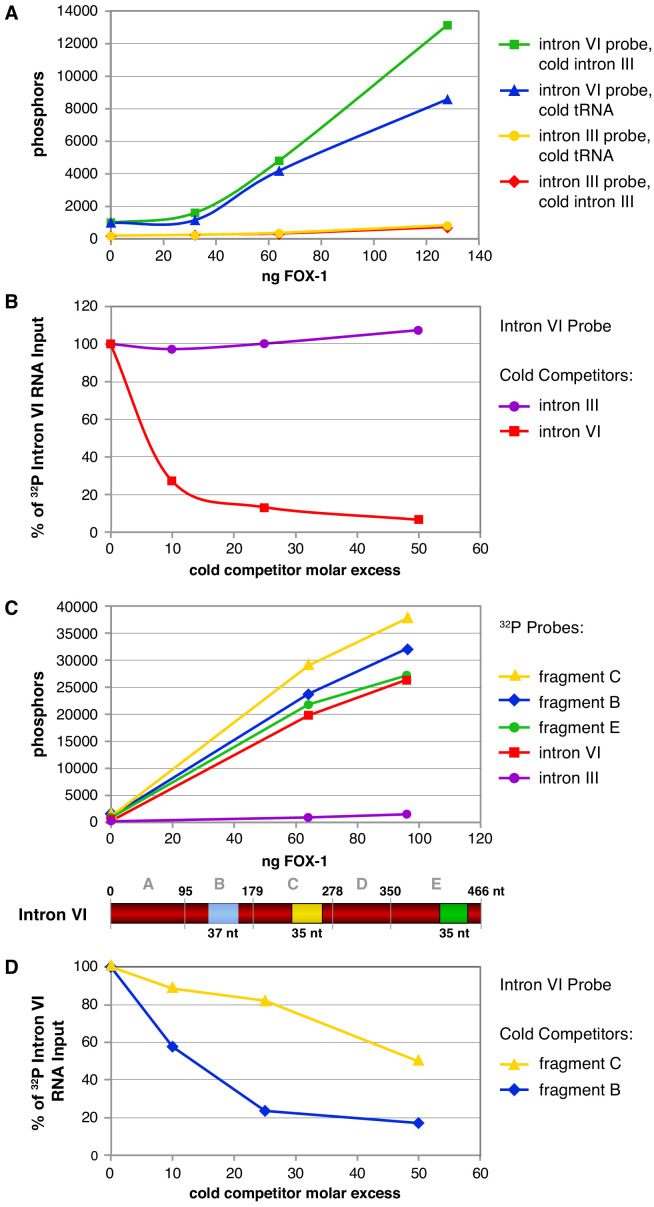
Cross-linking experiments show that FOX-1 binds directly to multiple sites in intron VI.(A) Graphs show cross-linking experiments comparing binding to 32P-labeled RNA probes of intact intron VI or intron III with different concentrations of purified FOX-1 protein and different cold RNA carriers to inhibit nonspecific FOX-1 binding. Compared are cold intron III RNA (100-fold molar excess) and cold tRNA (100-fold molar excess). FOX-1 binds directly to intron VI but not intron III. tRNA can partially reduce FOX-1 binding to intron VI. (B) Graphs show cross-linking competition experiments in which FOX-1 binding (32 ng) to 32P-labeled intron VI RNA was challenged with an increasing molar excess of either cold intron VI or cold intron III RNA. Intron III RNA does not compete with 32P-labeled intron VI RNA for binding to FOX-1, consistent with it not binding FOX-1 in (A). Binding is expressed as the percent of 32P intron VI RNA bound by FOX-1 without any competitor RNA. Based on experiments in (A) and (B), cold intron III was chosen as the cold carrier for subsequent cross-linking experiments (C) Multiple subregions within intron VI bind directly to FOX-1. Graphs show the results of cross-linking experiments between different concentrations of purified FOX-1 protein and 32P-labeled probes of intact intron III, intron VI, and subregions within intron VI. The diagram of intron VI below the graphs shows the subregions tested for direct binding in vitro. These graphs show that only B, C, and E can bind FOX-1, but they do not reveal the relative binding affinities of the different fragments. (D) Graphs show cross-linking competition experiments in which FOX-1 binding (32 ng) to 32P intron VI RNA was challenged with an increasing molar excess of cold fragment B or cold fragment C RNAs. These graphs confirm that FOX-1 binds to the B and C subregions of intron VI.